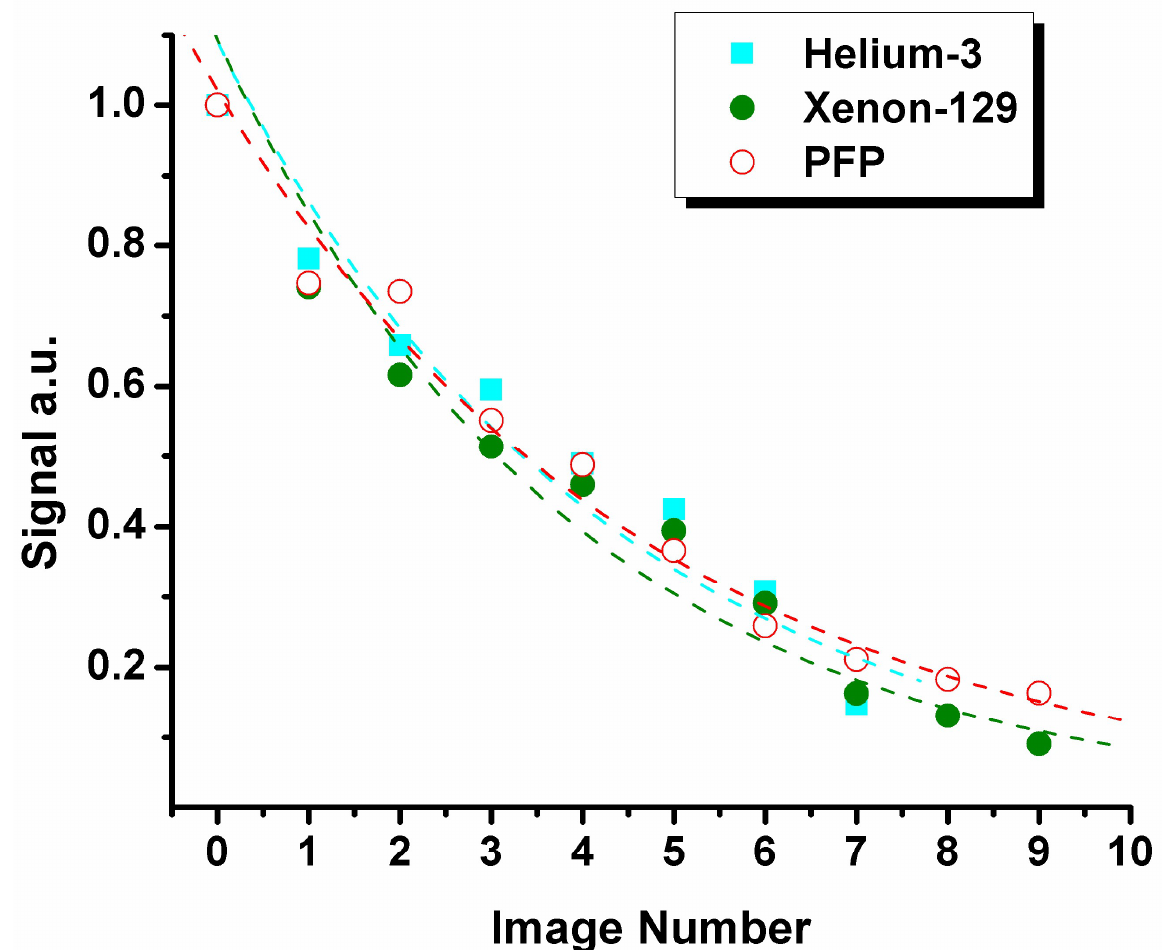
Figure 2. Bulk signal intensity dependence as a function of image number obtained from wash-out rat lung images (Figure 1A). The dashed lines show the best-fit of mono exponentials obtained from Figure 1A.